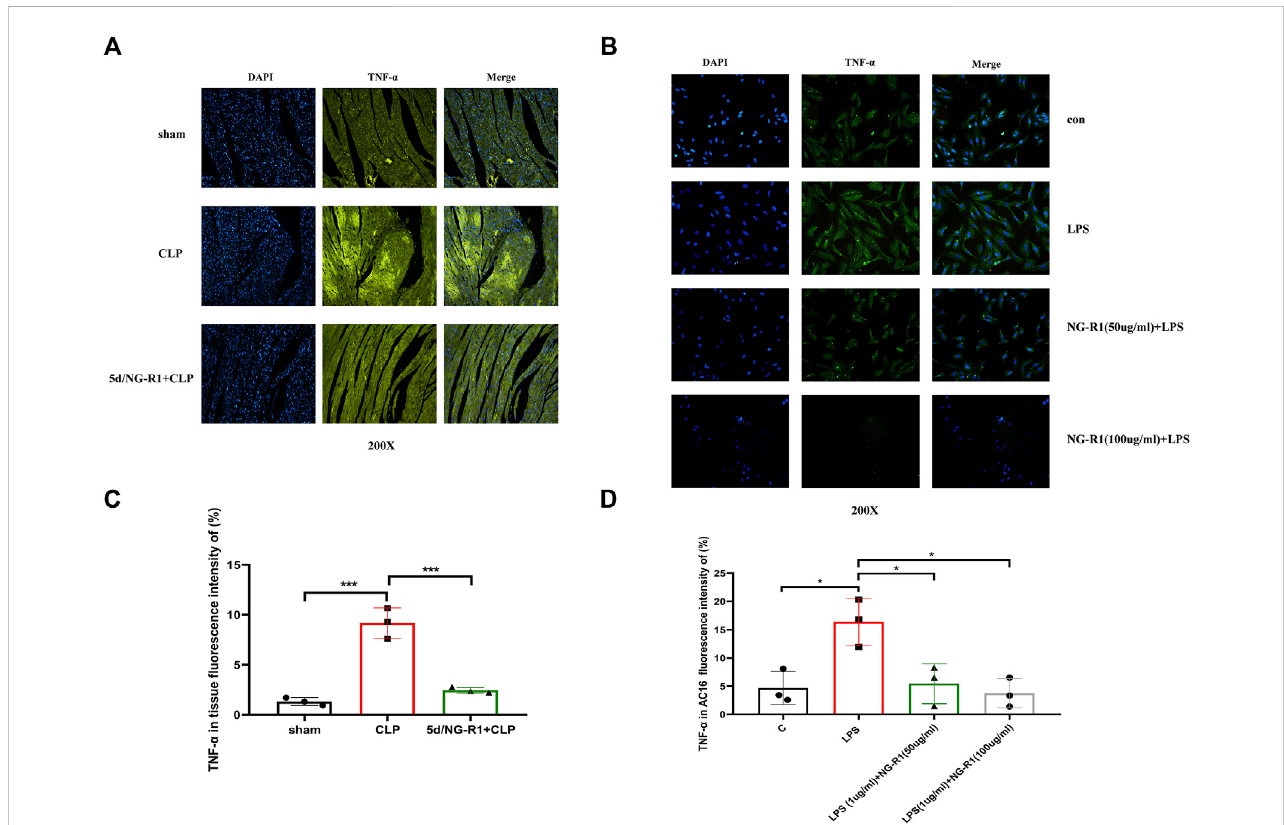
FIGURE 8 NG-R1 reduces TNF- α expression in myocardial tissues and AC16 cardiomyocytes. (A, C) TNF- α immuno fl uorescence expression in mice tissues, fl uorescence intensity statistics (n = 3 per group) (200X). (B, D) TNF- α immuno fl uorescence expression in AC16 cardiomyocytes, fl uorescence intensity statistics (n = 3 per group) (200X). The data are represented as means ± SD; * p < 0.05, *** p <